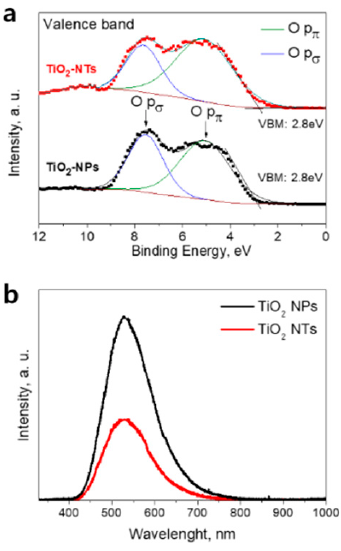
Figure 2. ( a ) Valence band X-ray photoelectron spectroscopy (XPS) spectra of pristine TiO 2 NPs- and TiO 2 NTs-based layers (symbols) and its Gaussian fit of XPS spectra (solid lines). ( b ) Photoluminescence (PL) spectra of NPs- and NTs-based TiO 2 layers taken at 10 K.